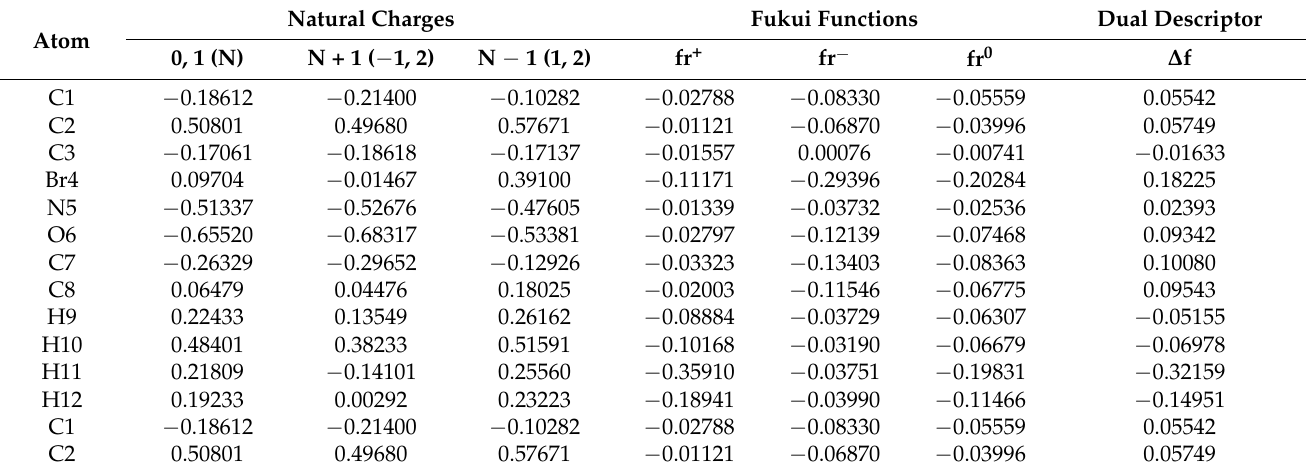
Table 6. Natural population distribution, Fukui functions and dual descriptor of the title compound.